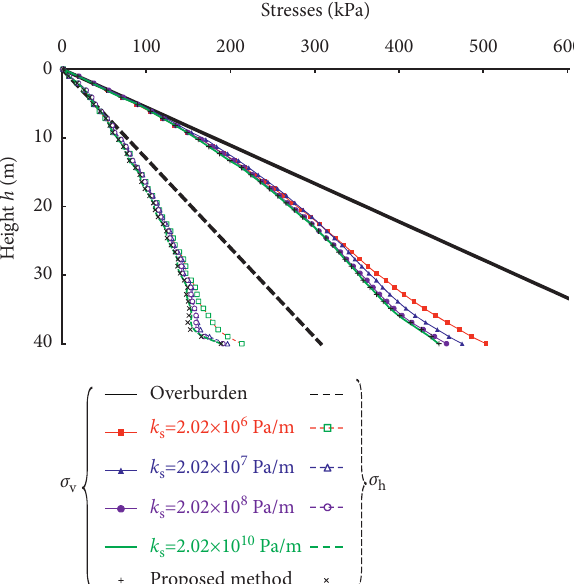
Figure 3: Vertical ( σ v ) and horizontal ( σ h ) stresses plotted along VCL of stopes with different normal stiffness (k) n of interfaces in open stoping with subsequent backfill mining.